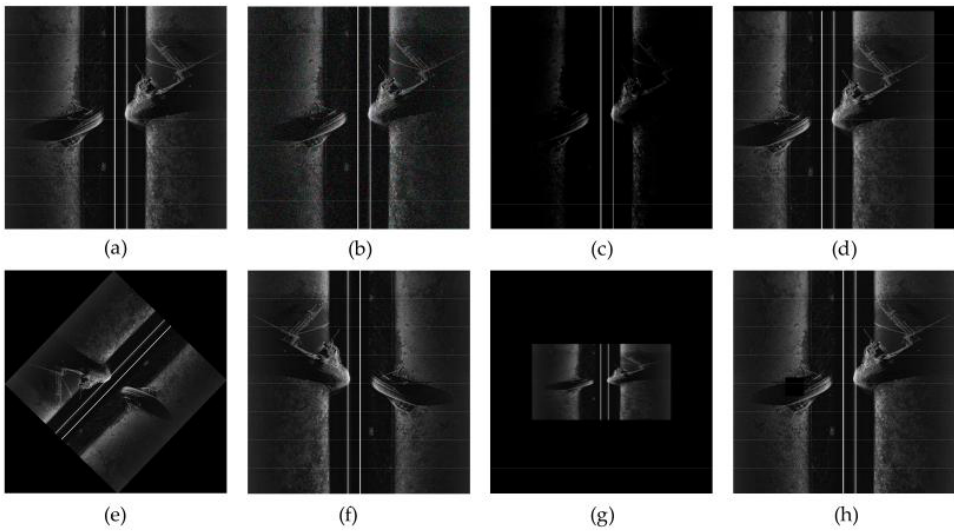
Figure 13. Data augmentation. ( a ) denotes the raw SSS image; ( b – h ) are the results of data augmen- tation by the Gaussian noise, the brightness change, the image translation, the rotation, the flip, the zoom and the cutout.